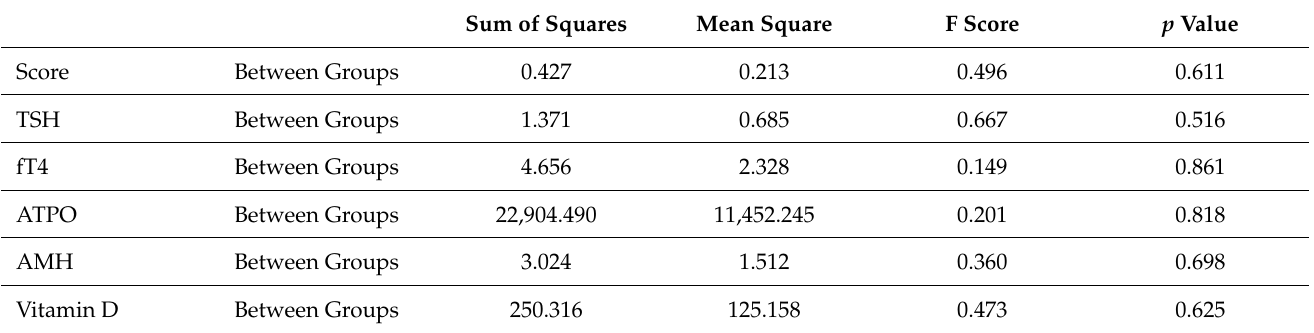
Table 3. Comparison of biohumoral parameters for the patients included in the analyzed subgroups.